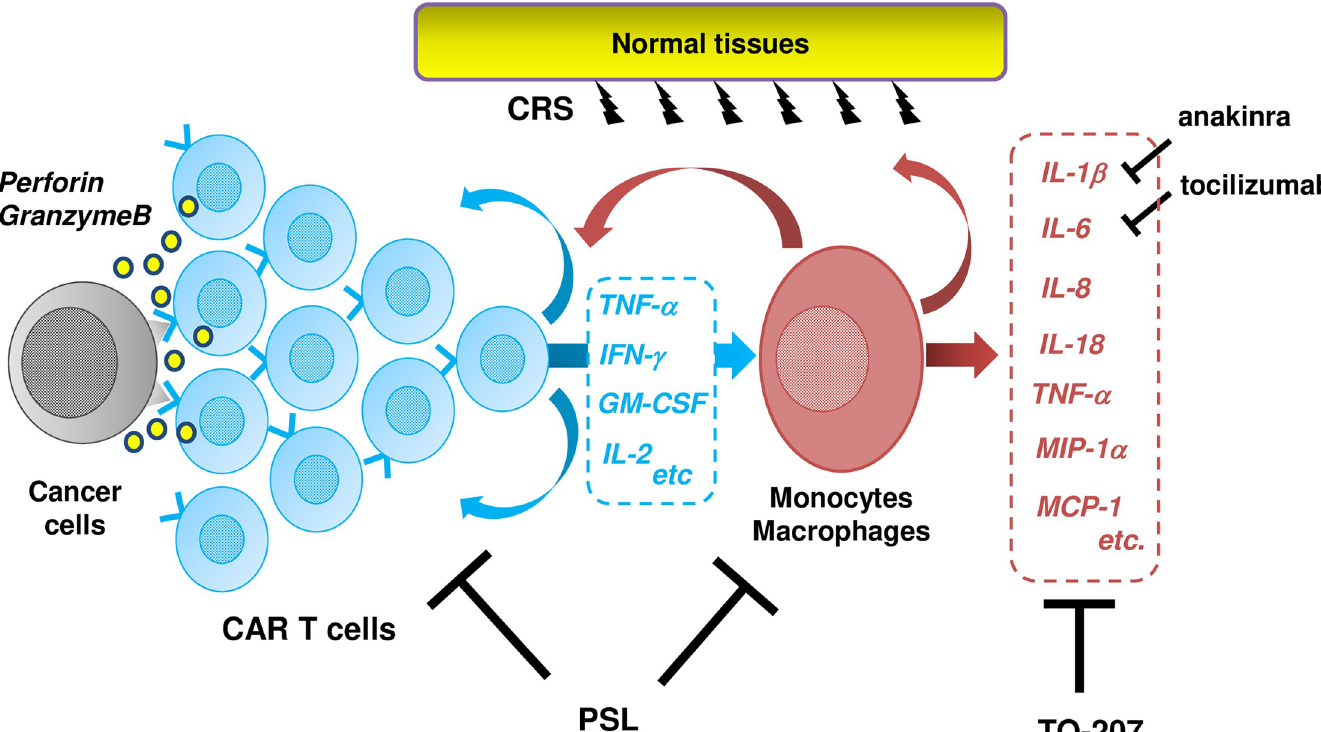
Fig 6. Targeted effects of TO-207 on monokine production. Interactions among cancer cells, CAR T cells, and monocytes and macrophages in CRS, and therapeutic actions of PSL, TO-207, anakinra, and tocilizumab. PSL suppressed cytokine production derived from T cells and monocyte and macrophages while attenuating the cytotoxic effects of CAR T cells, whereas TO-207 suppressed monokine production without disturbing the cytotoxic effects of CAR T cells. Anakinra and tocilizumab did not exert suppressive effects on cytokines other than their specific targets.